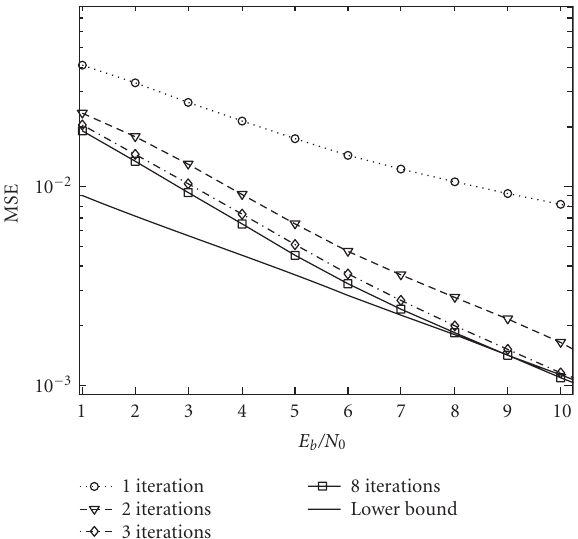
Figure 4: Mean square error of the iterative receiver for the overlay OFDM system with QPSK